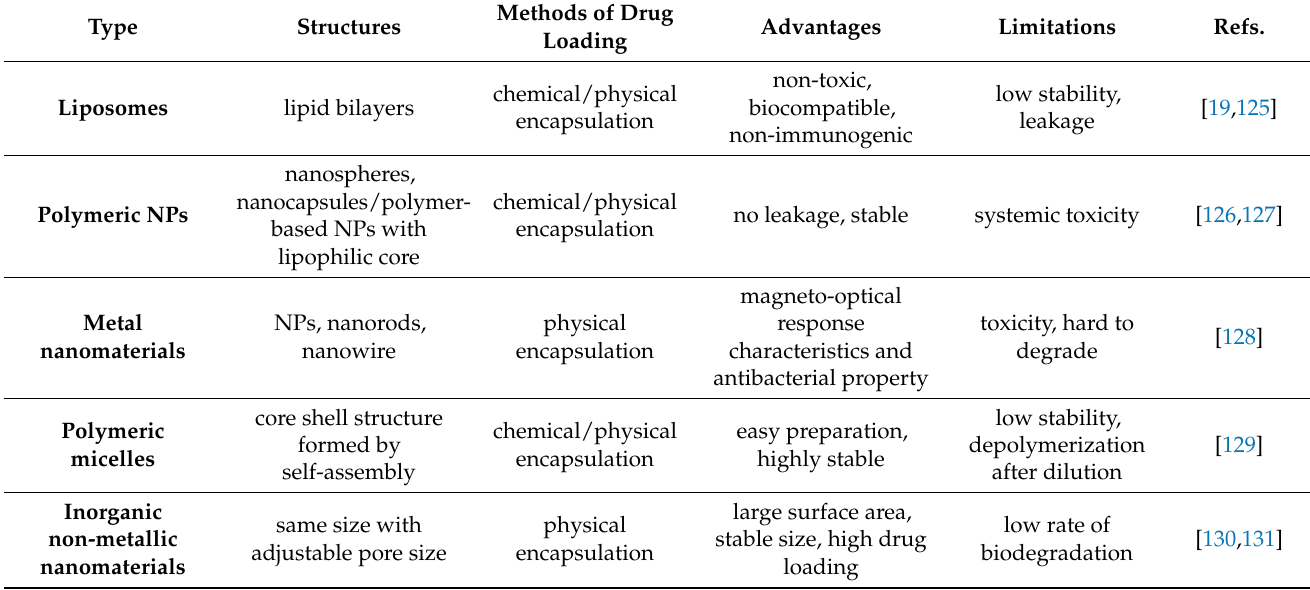
Table 2. Category and features of nanodrug carriers for the treatment of CVDs.